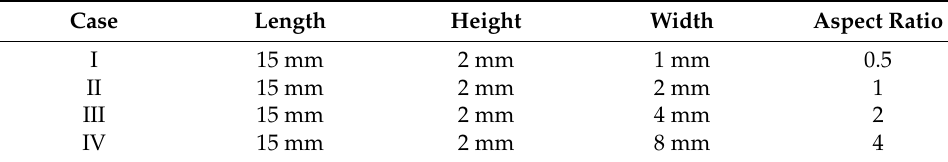
Table 11. Dimensions of the single torsion